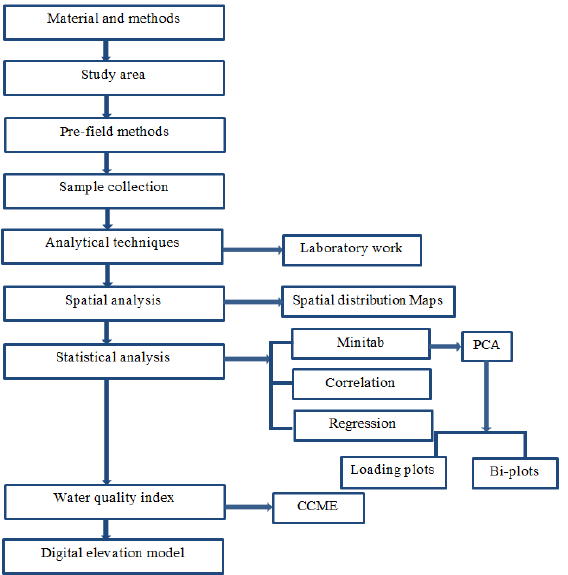
Figure 2. Flow chart showing the general methodology .